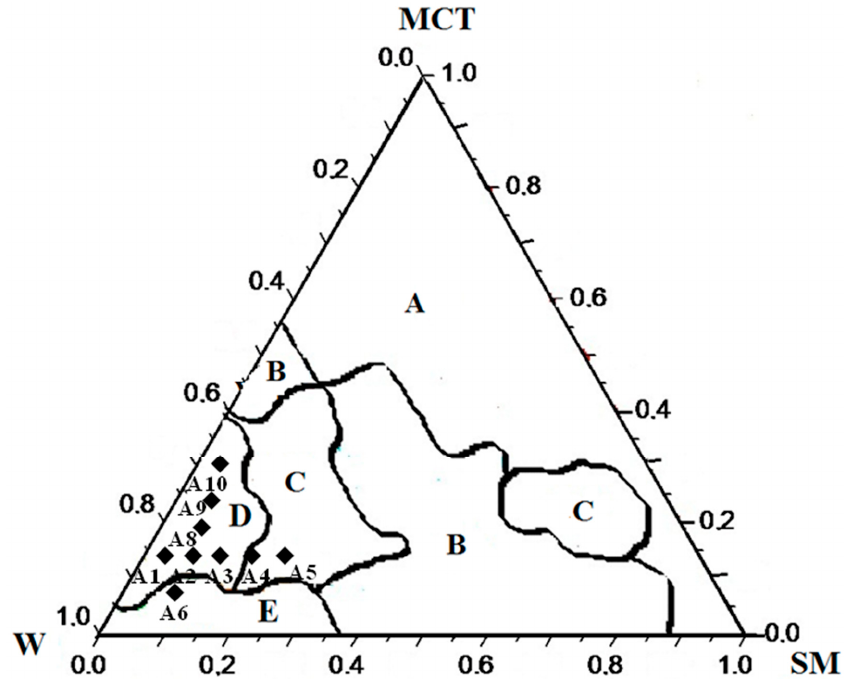
Figure 2. Pseudo-ternary phase diagram involving MCT stabilized with the surfactant mixture (SM) SPC/SO at HLB = 16 in purified water (W): (A) phase separation, (B) creams, (C) liquid crystals, (D) nanoemulsions and (E) emulsions.